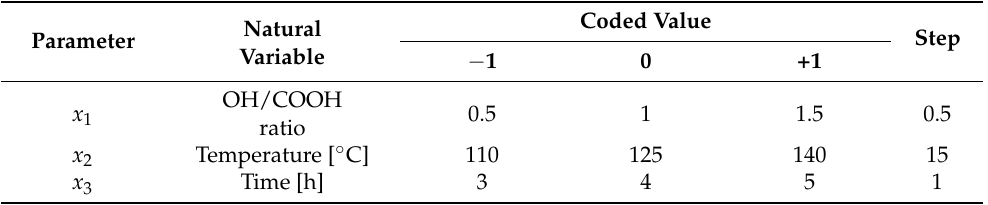
Table 3. Box–Behnken Design—coding